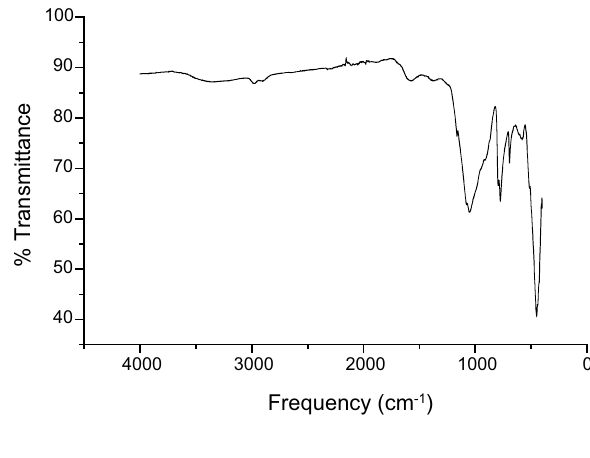
Fig. 1 FTIR spectrum of WM-Fe